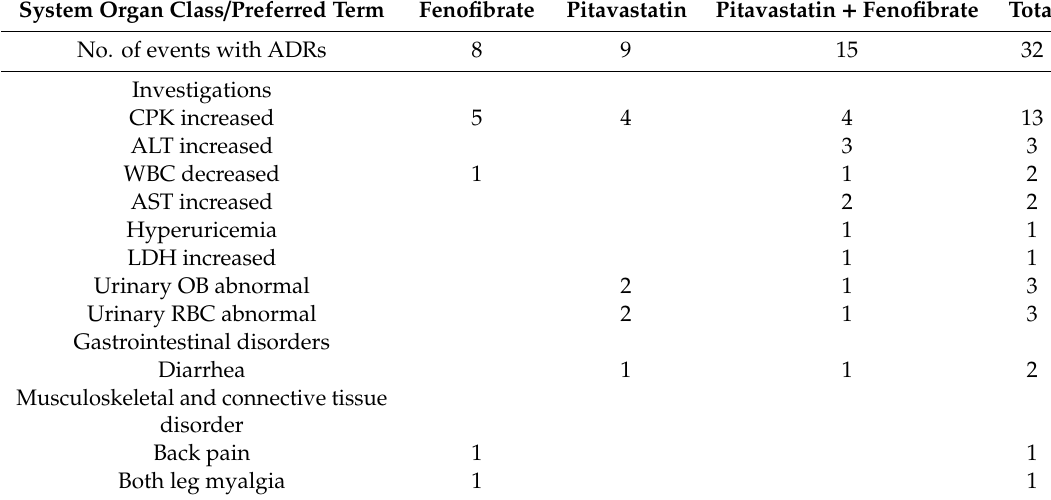
Table 3. Adverse drug reactions (ADRs) that were reported following multiple oral administration of 160 mg of micronized fenofibrate and / or 2 mg of pitavastatin in 24 healthy subjects. System Organ Class / Preferred Term Fenofibrate Pitavastatin Pitavastatin + Fenofibrate Total No. of events with ADRs